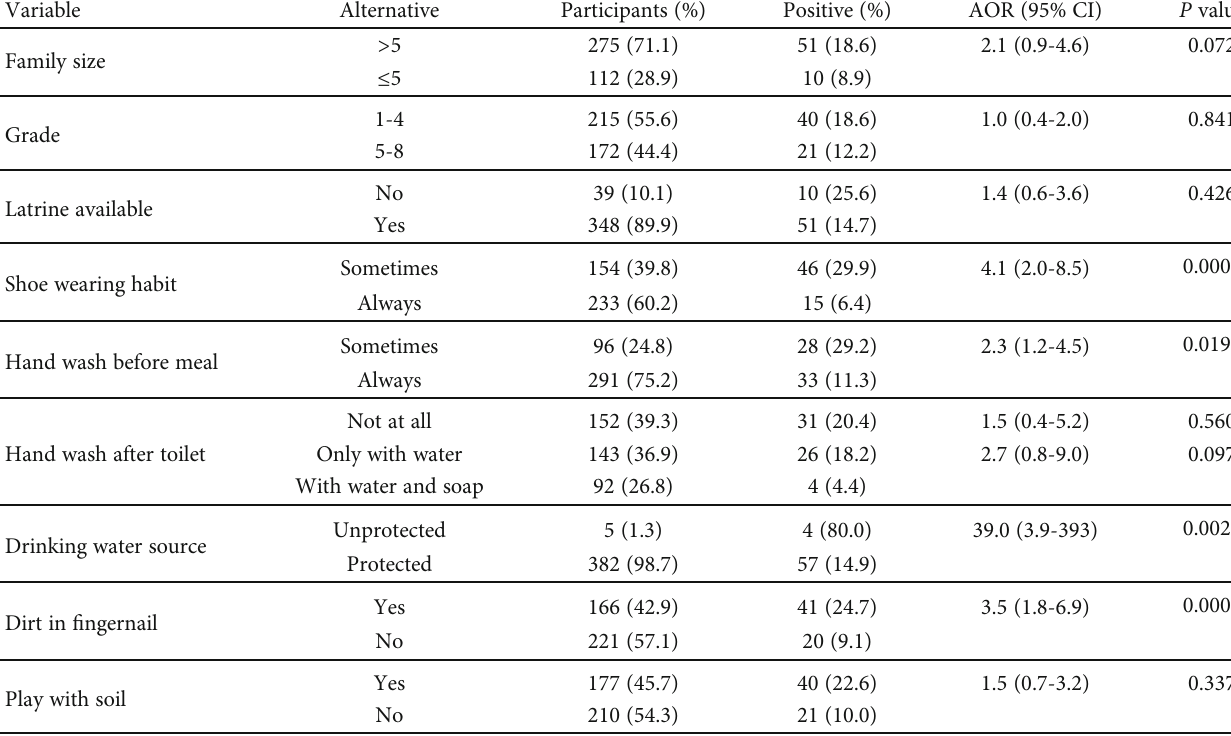
Table 3: Factors associated with STH among school-age children at Gora Elementary School, Southwest Ethiopia,